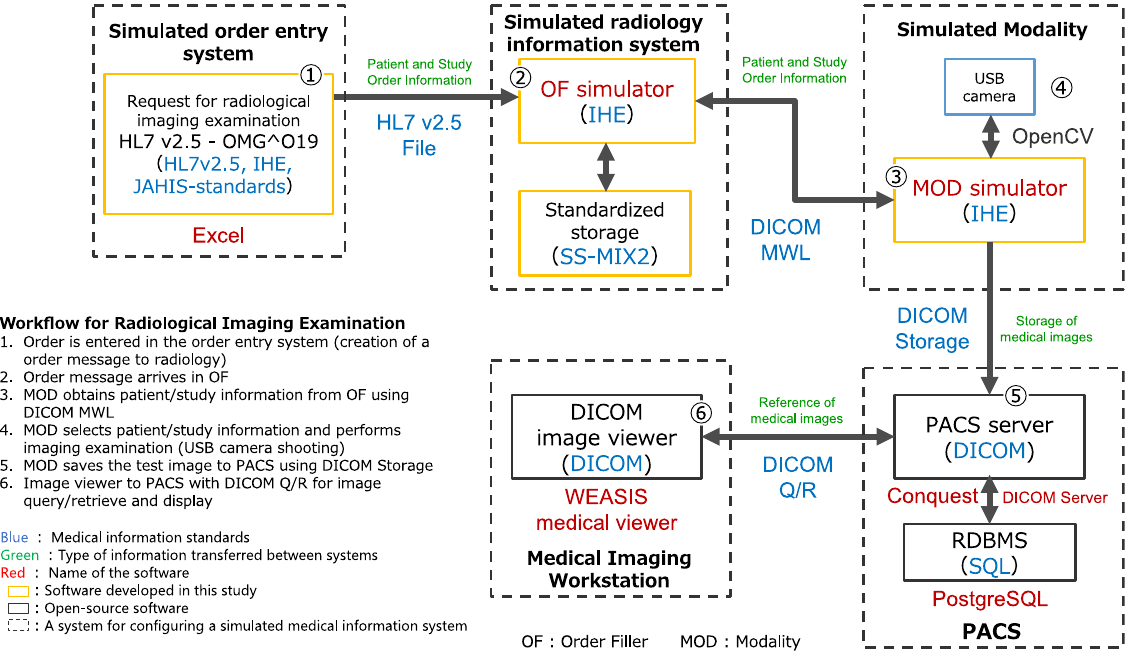
Figure 1 The system diagram of the simulated medical information system (SMIS) used in this